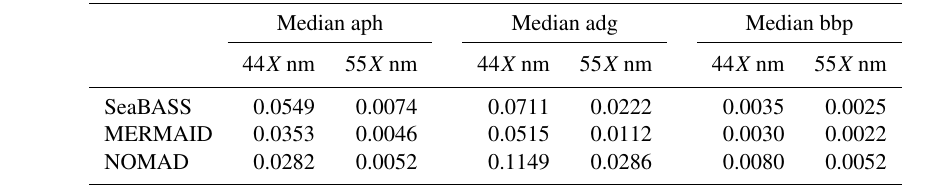
Table 3. Summary of median values for aph, adg and bbp at 44 X and 55 X nm for each dataset (as shown in Fig. 12a–f). Data were first searched at 445 and 555nm and then with a search window of up to 8nm to include data at 547nm.